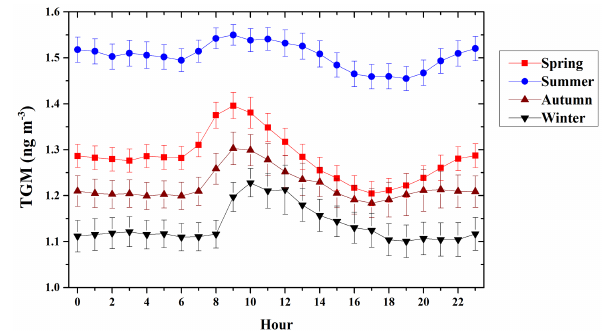
Figure 6. Diurnal profiles of average hourly TGM at the Nam Co Station by seasons during the measurement period. Error bars are 95% confidence levels.